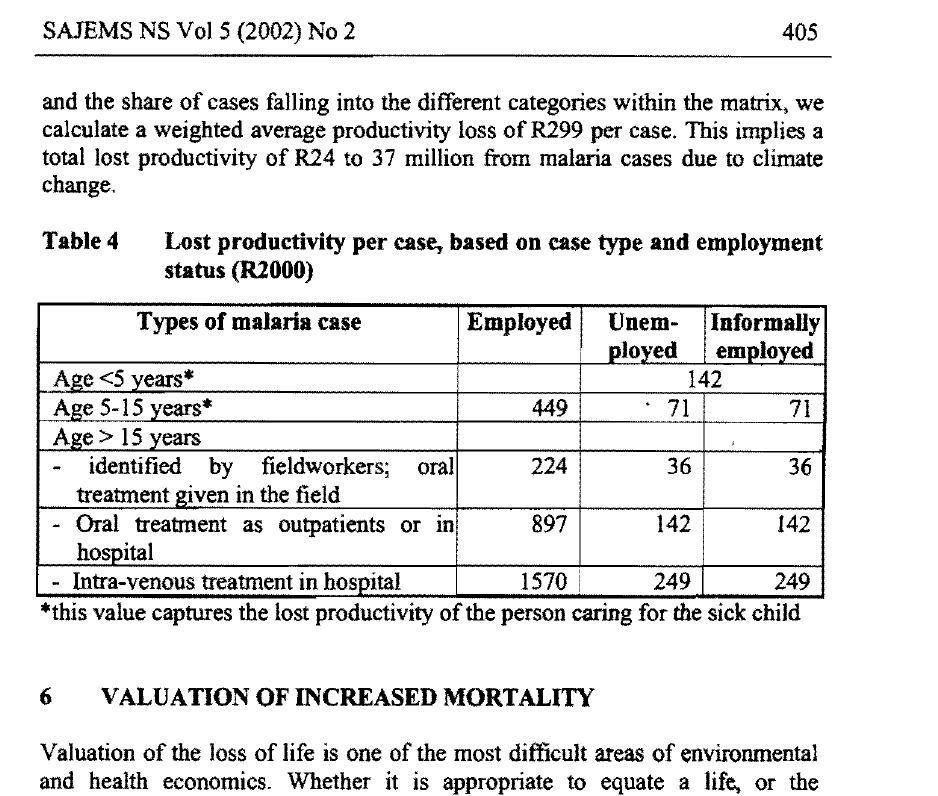
Lost productivity per case, based on case type and